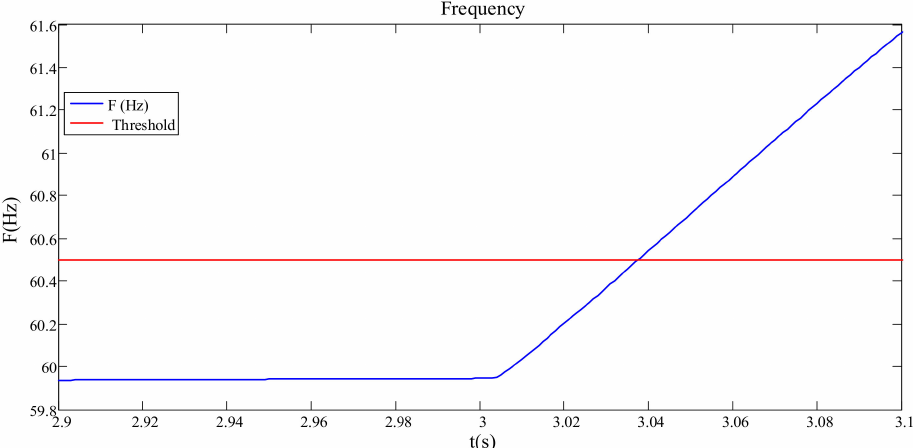
Figure 6. The output of OF / UF relay in islanding mode with high power